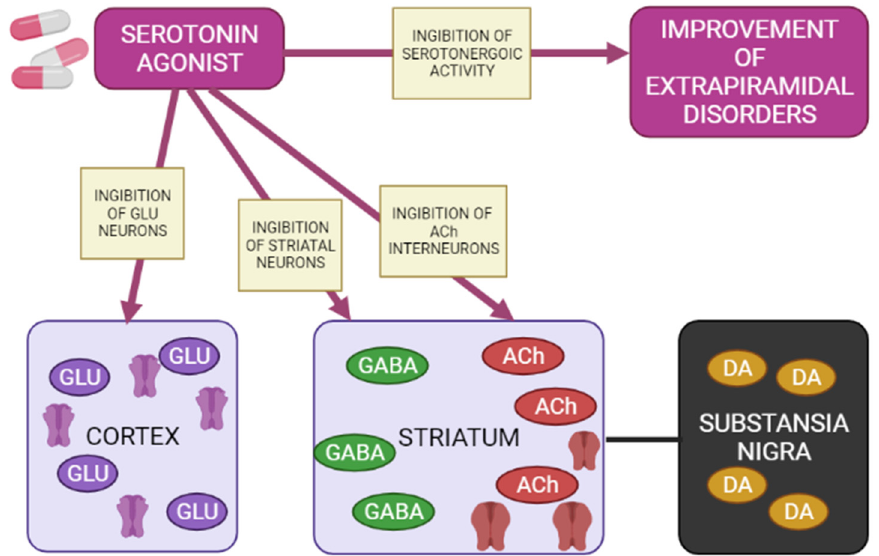
Figure 5. Mechanisms of action of a 5-HT1A agonist in modulating extrapyramidal motility disor- ders (Adapted from [65], Copyright year 2012, Adv. Biol. Psychiatry). Note: GLU—glutamate;